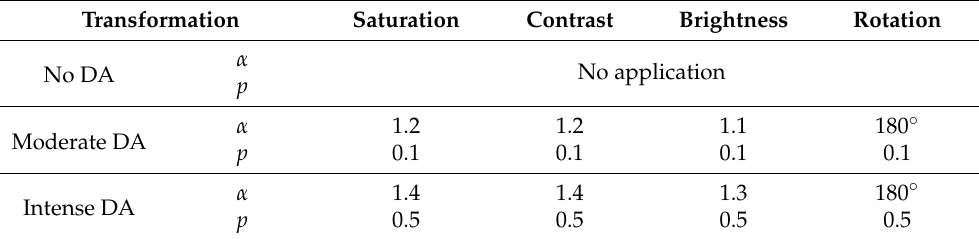
Table 4. Implemented data augmentation strategies.